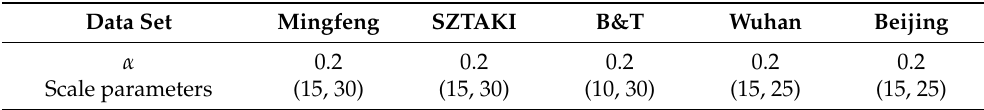
Table 1. Parameter